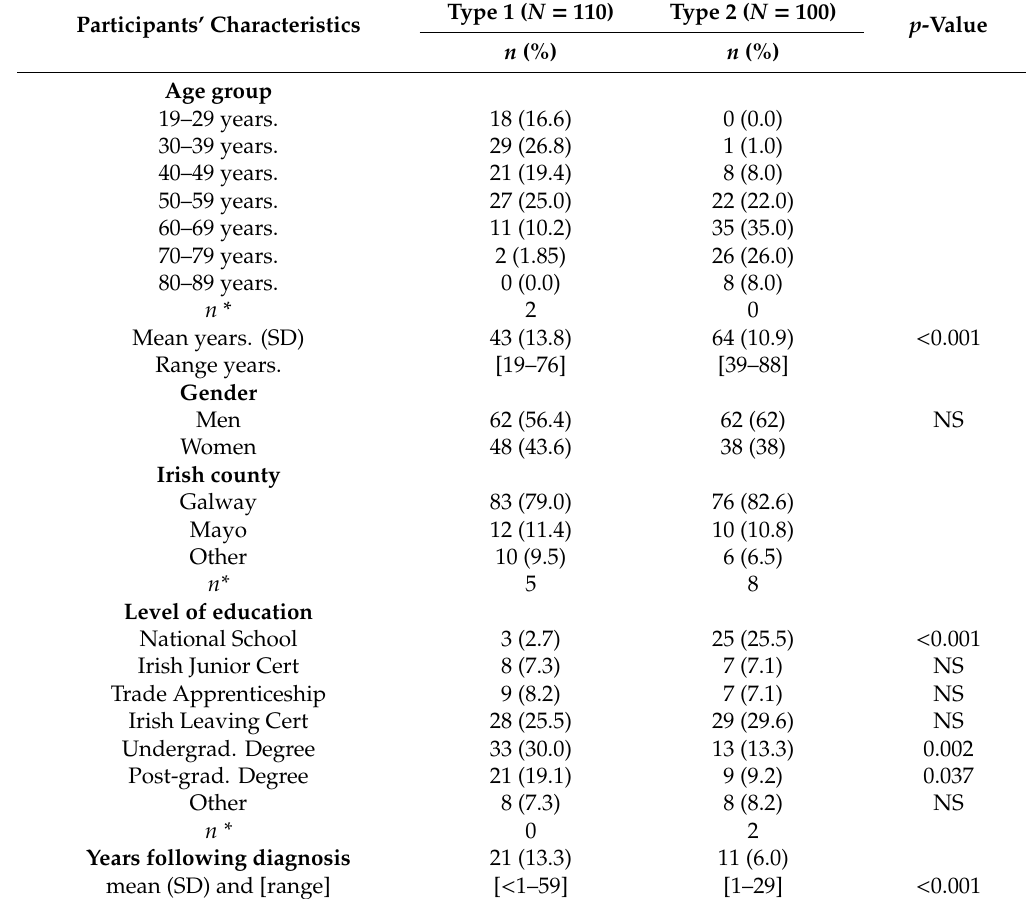
Table 1. Socio-demographic and clinical data of